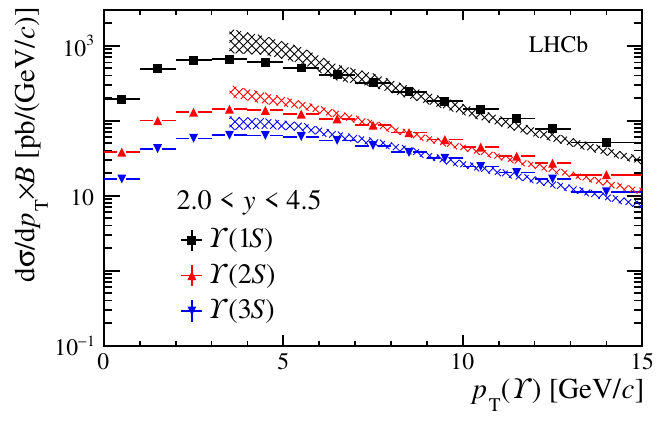
Figure 3 . Di(cid:11)erential cross-sections multiplied by dimuon branching fractions for the (cid:7) (1 S ) (black solid squares), (cid:7) (2 S ) (red upward triangles) and (cid:7) (3 S ) (blue downward triangles) states versus p T integrated over y between 2.0 and 4.5. Statistical and systematic uncertainties are added in quadrature. Predictions from NRQCD [2] for the (cid:7) (1 S ) (black grid shading), (cid:7) (2 S ) (red grid shading) and (cid:7) (3 S ) (blue grid shading) states are overlaid in the